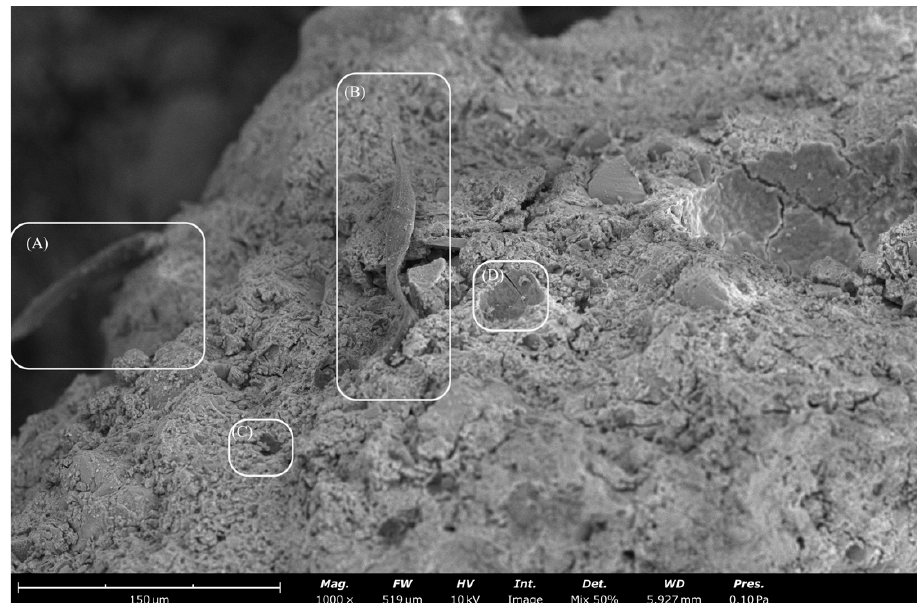
Figure 8. SEM images of fibres within concrete composite . ( A , B ) Retained fibre integrity, ( C , D ) Fibre snapping occurred.